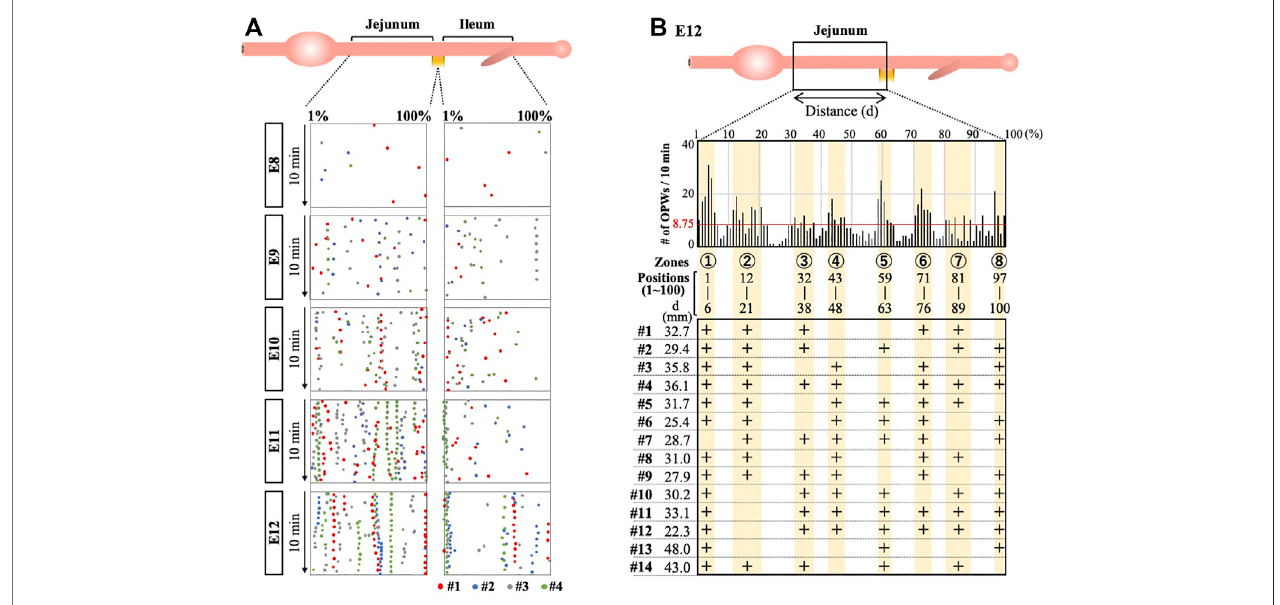
FIGURE3| OPWsinthejejunumareprogressivelycon fi nedtodistinctzonesduringgutdevelopment. (A) Distributionmapsoffourembryosareoverlaid(#1inred, Panel 2 ; #2 – #4 as shown in Supplementary Figure S2 ). Dots in different colors progressively converge to distinct sites along the midgut. (B) Eight distinct zones (yellow) preferentiallyaccommodateOPWsinthejejunum atE12.Thetotalnumberofdots(OPWs)for14embryosis875,andtheaverageperonepositionis8.75(875/ 100;horizontalredline).Theeightzonescontainclustersofpositionswitheachshowingabove8.75.Thezonesallowtwoconsecutivepositionshavingbelow8.75. The lower panel shows the usage of these zones in each embryo (#1 – #14). See text for details.